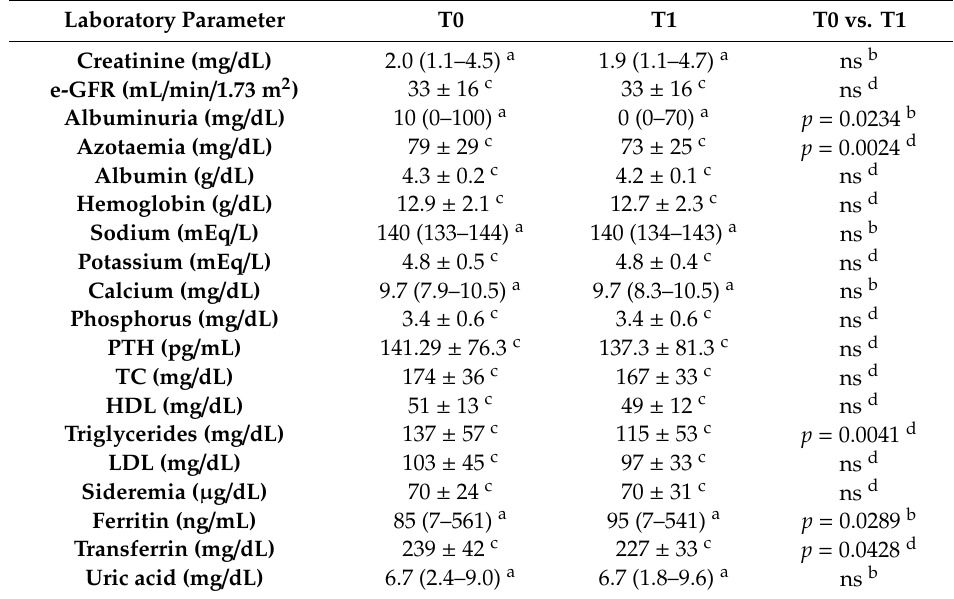
Table 2. Routine laboratory parameters of chronic kidney disease (CKD)